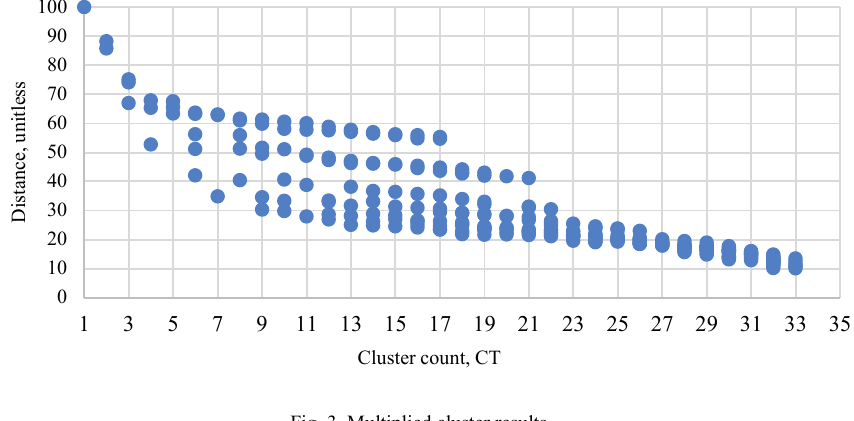
Fig. 3. Multiplied cluster